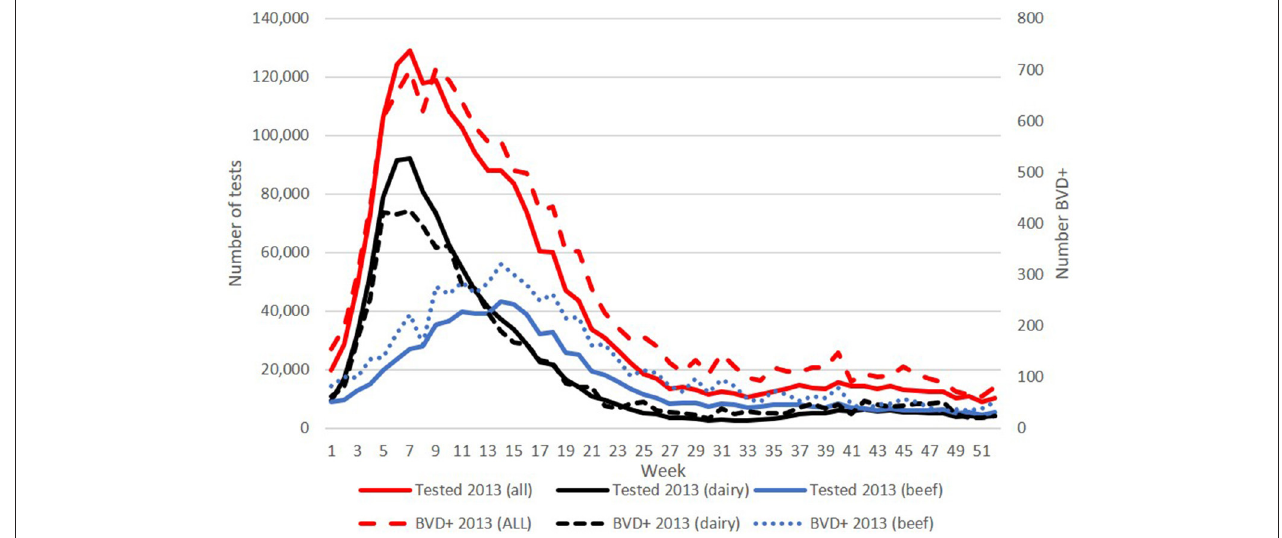
FIGURE 2 | Weekly number of calves tested (left y-axis) overall, and from dairy and beef herds in 2013 (solid lines), and the corresponding number of BVD + calves (right y-axis) detected each week (broken lines). BVD + calves are those with an initial positive or inconclusive result without a negative retest result.